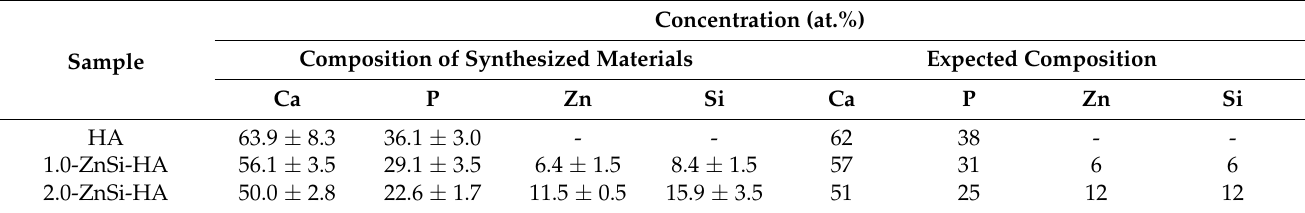
Figure 6. Distribution map of elements across particles in 2.0-ZnSi-HA sample. Data obtained by TEM measurement. Table 2. Results of ICP-AES analysis of the as-synthesized samples. Concentration Sample